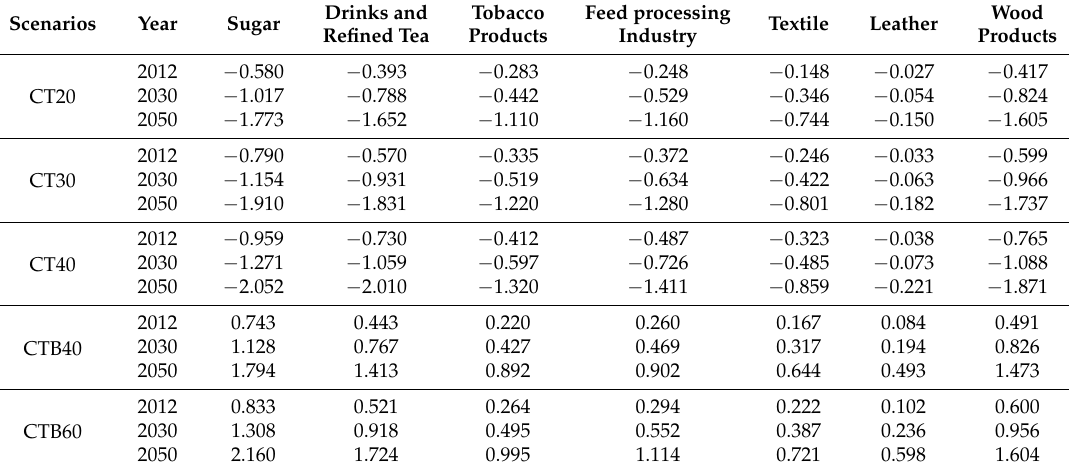
Table 7. The changes in the return on capital in agriculture-related sectors under different scenarios compared with the BAU scenario (%) (from sugar to wood